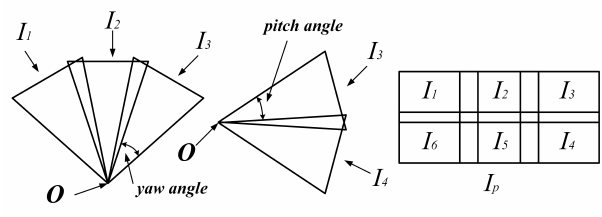
Figure 3. Diagram showing the panoramic capture process for a single camera, where I k ( k = 1,2,...,6 ) = image, I p = combined panorama, and O = optical center of the